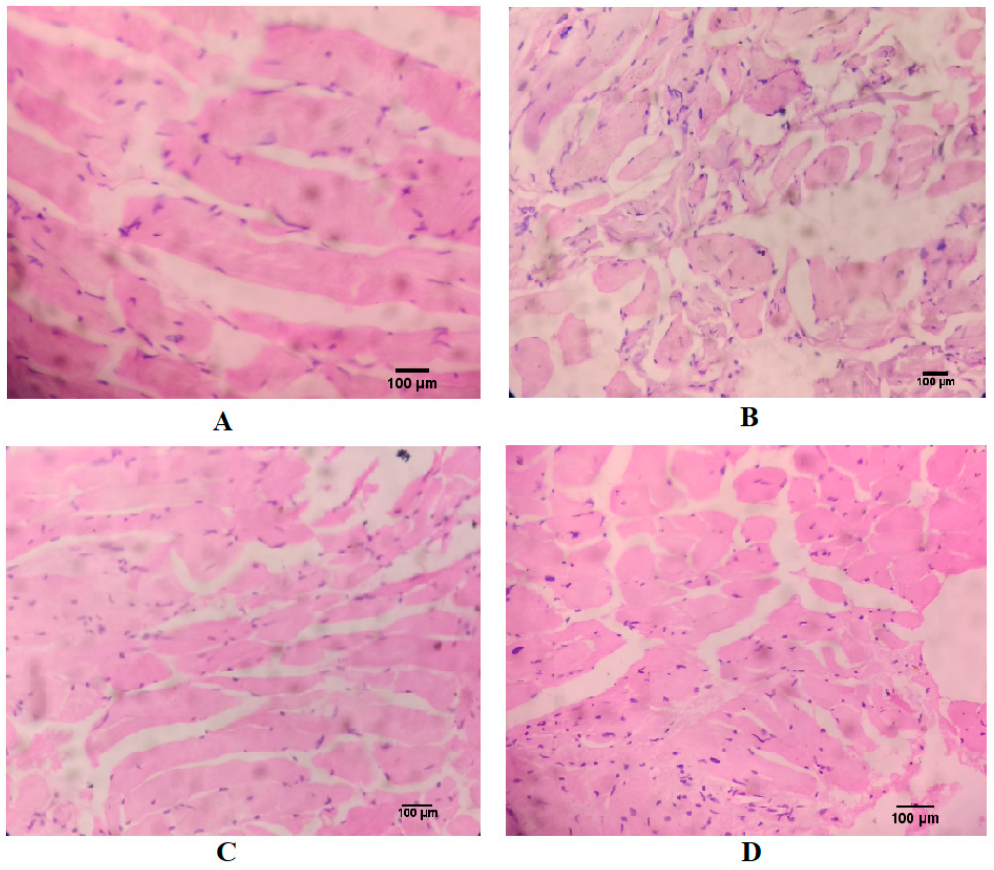
Figure 4. Effect of AKBA on histopathological changes in ovariectomized rats. ( A ) Sham control. ( B ) Ovariectomized control. ( C ) Ovariectomized animals treated with estradiol (0.05 mg/kg). ( D ) Ovariectomized animals treated with AKBA (35 mg/kg). AKBA: acetyl-11-keto- β -boswellic acid.